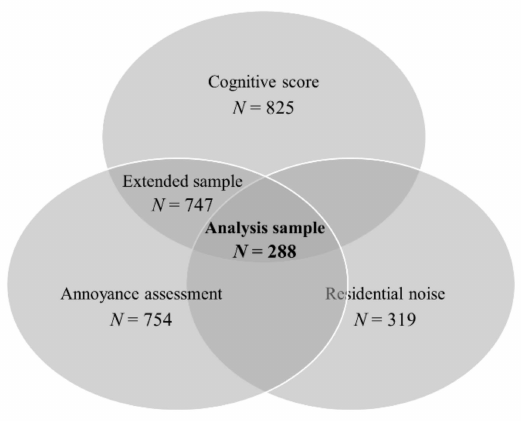
Figure 1. Numbers of participants with non-missing cognitive function and noise